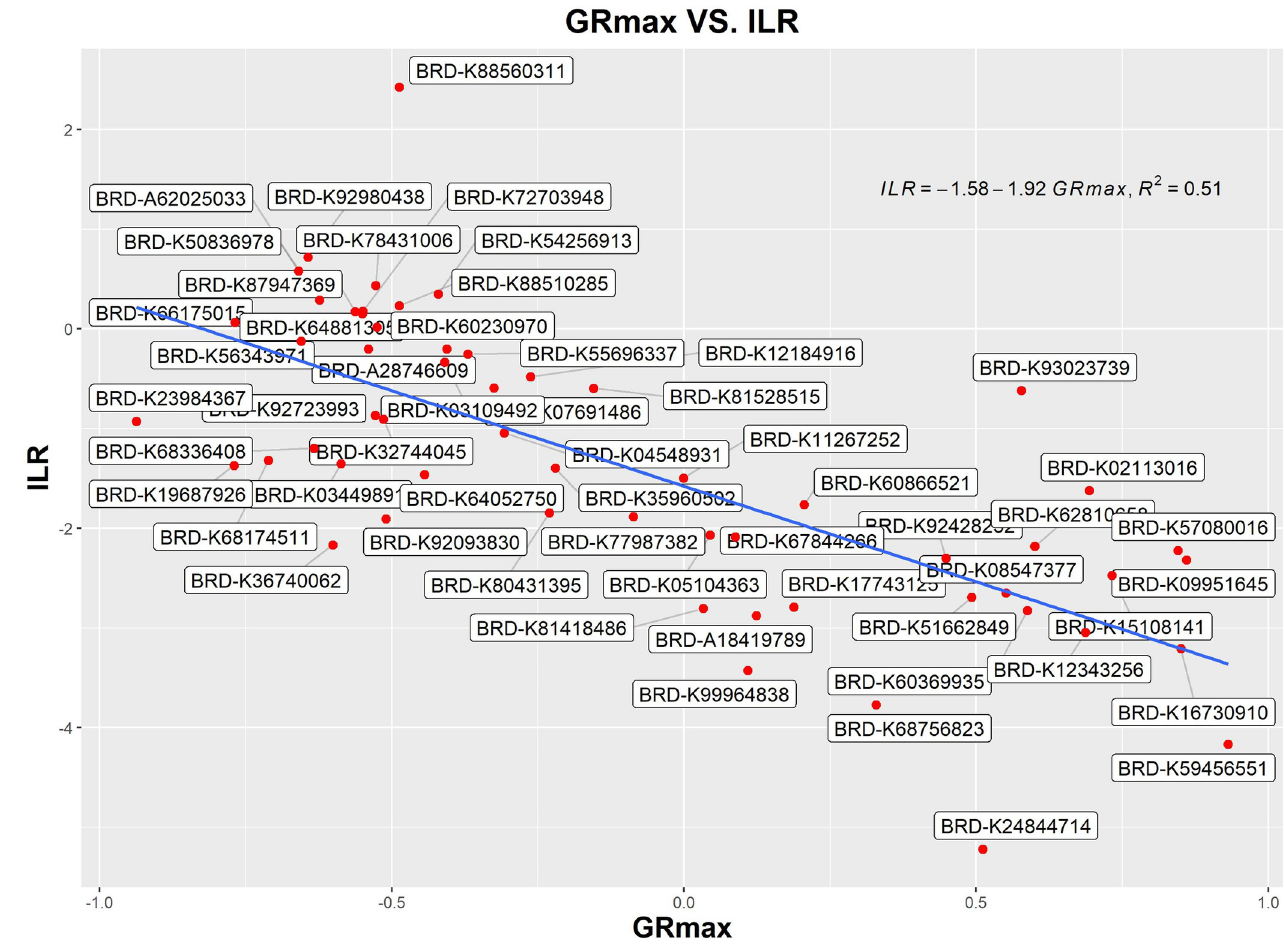
Fig 8. Linear regression of ILR of a drug OMU vector against GRmax of the same